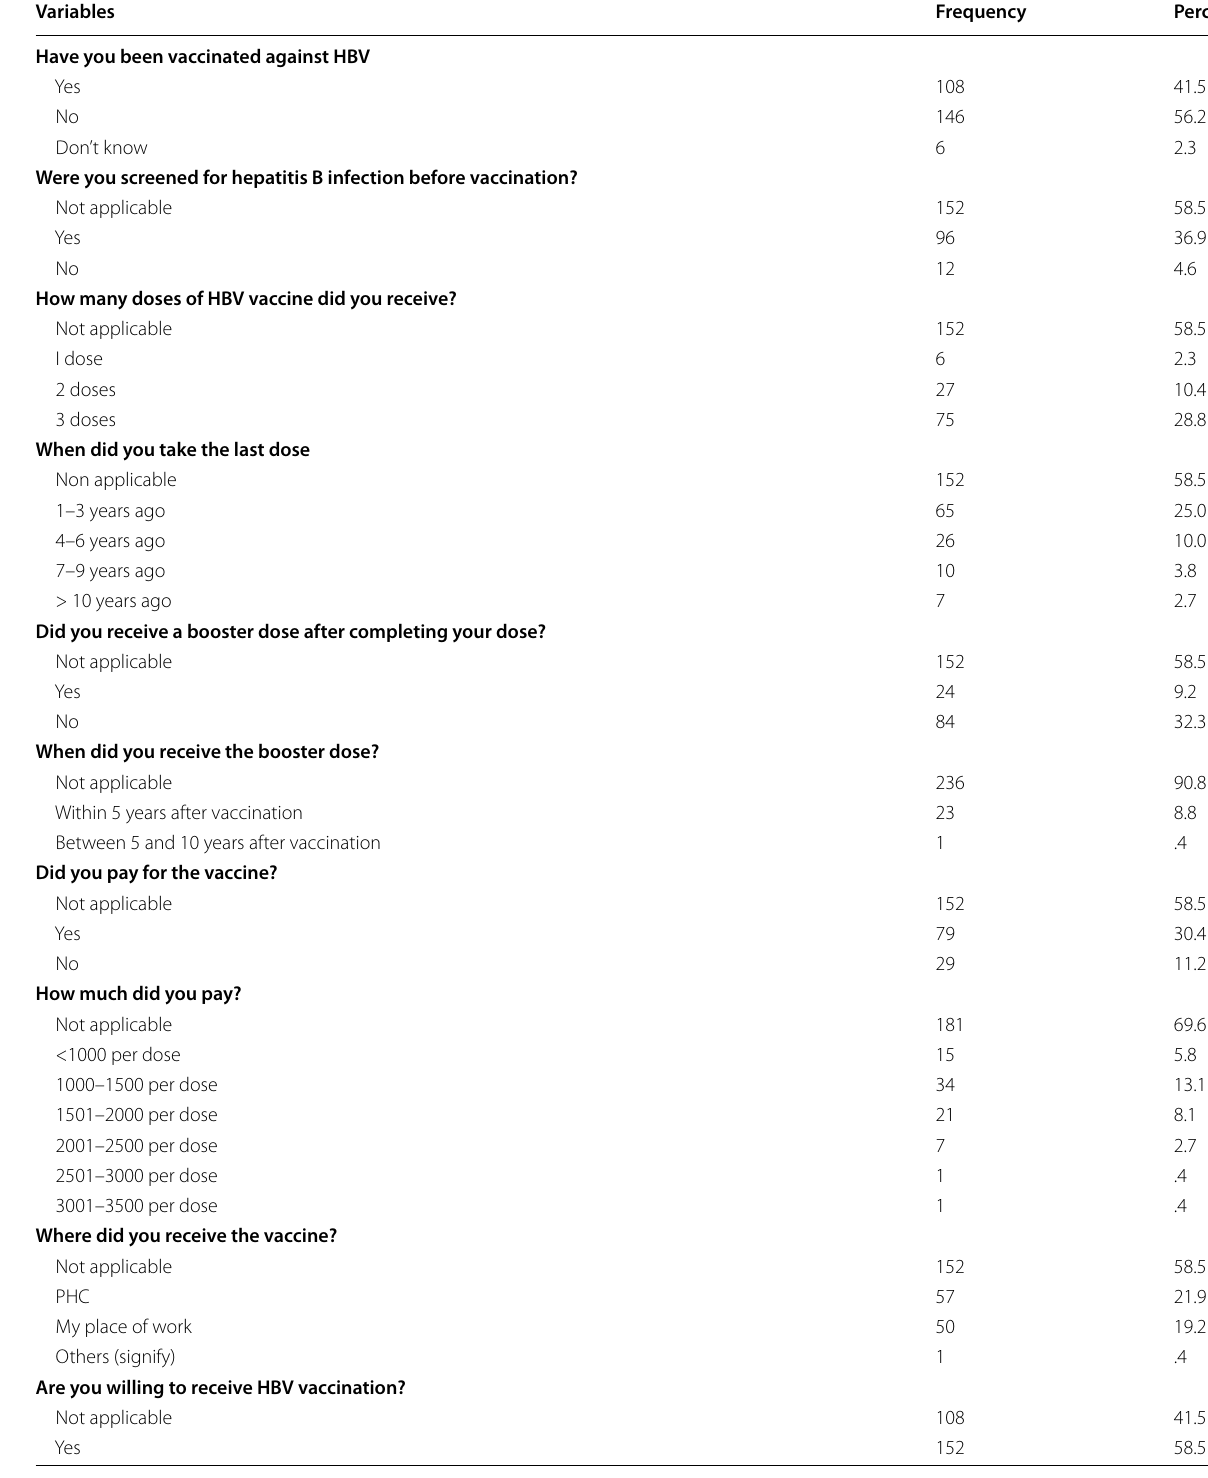
Table 3 HBV vaccine practice attitude ( N